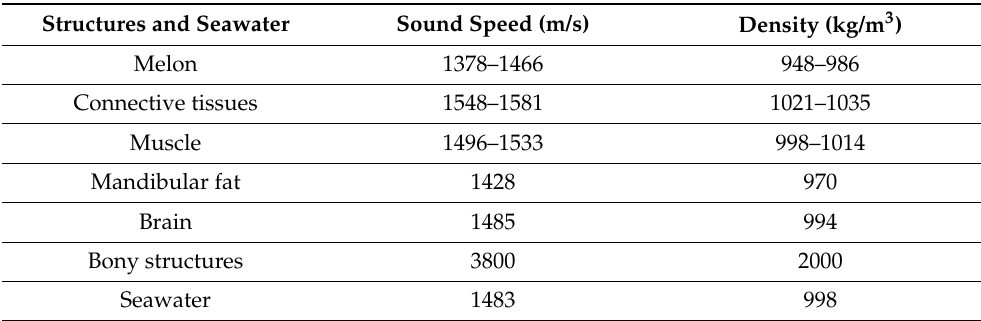
Figure 3. Geometric reconstruction of 2D models. ( A ) Vertical model reconstruction; the vertical slice cuts through the right phonic lips; colors represent the different acoustic impedance values. ( B ) Horizontal model reconstruction; the horizontal slice cuts through the two phonic lips and was on the major axis of the animal’s biosonar beam. ( C ) Reconstruction of the “cleftless” model. Filling of the cleft in red. For display purposes, the mesh layouts are illuminated in reduced resolution. Table 1. Average values of sound speed and density of the structures and seawater in the FE models.